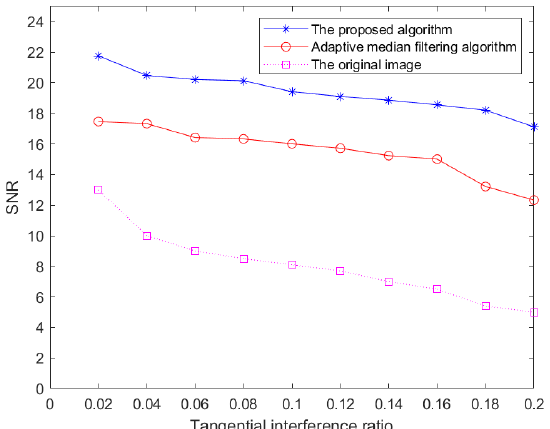
Figure 7. Relationship between SNR and tangential interference ratio of images processed by differ- ent